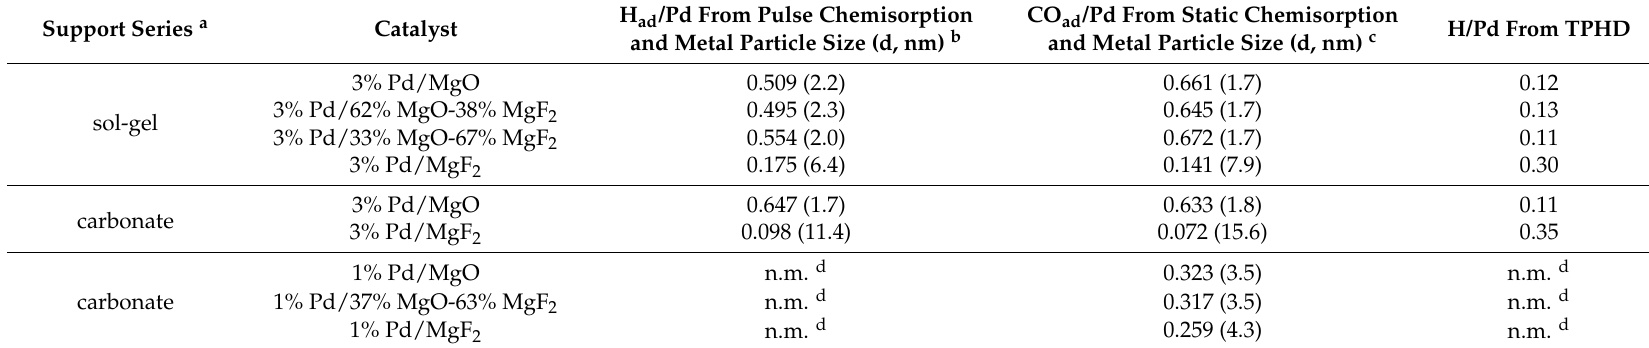
Table 2. Characteristics of Pd/MgO-MgF 2 catalysts: palladium dispersion and H/Pd ratio from Temperature Programmed Hydride Decomposition